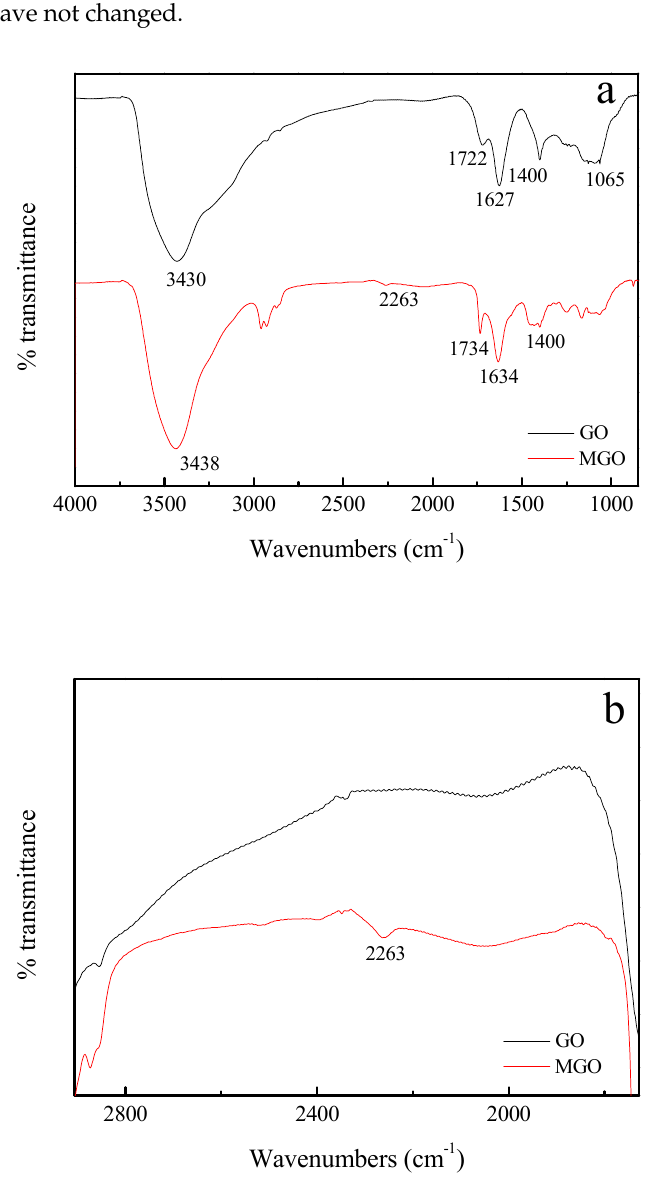
Figure 1. FTIR spectra ( a ) and partially enlarged views ( b ) of GO and MGO.